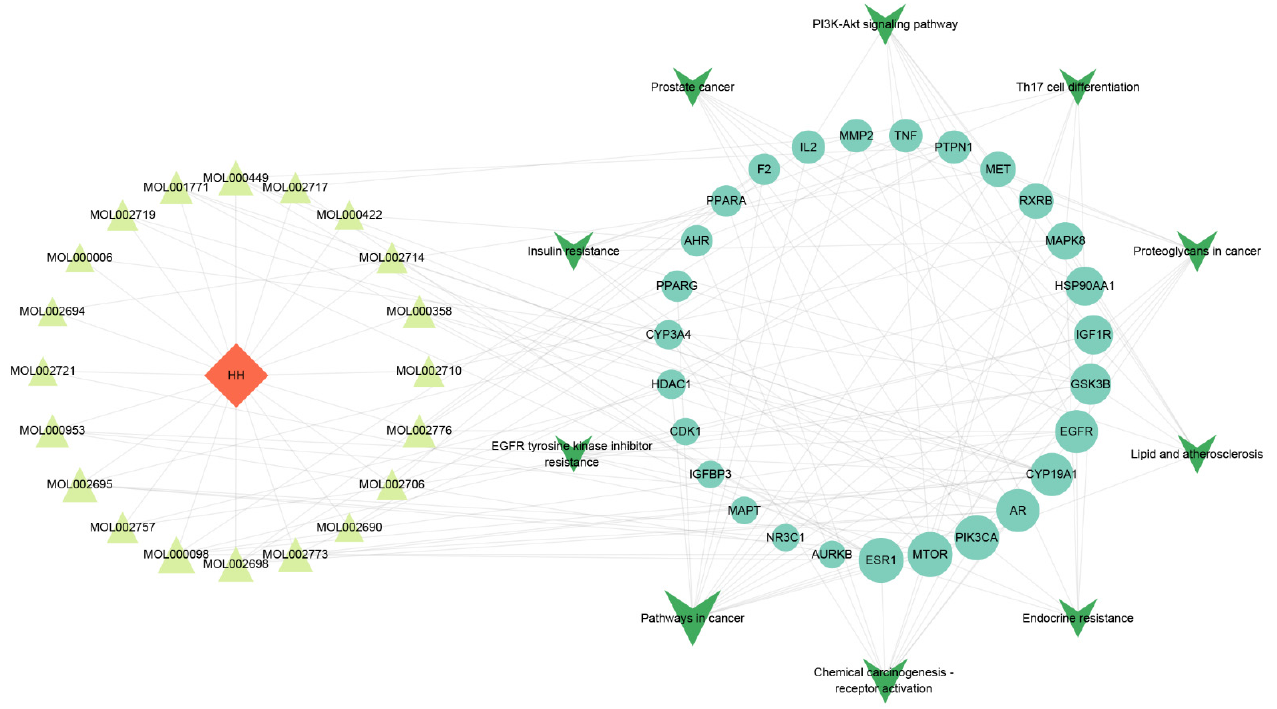
Figure 8. The schematic diagram of drug–component–major target–pathway interactive network (Red node is HH; light green nodes are components; blue nodes are target genes; dark green nodes are KEGG pathways).